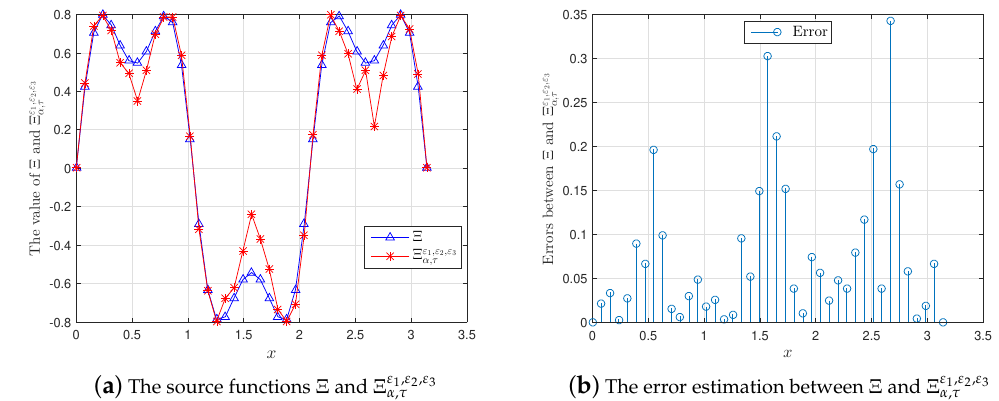
Figure 1. A comparison between Ξ and Ξ ε 1 , ε 2 , ε 3 α , τ for β = 1.5, X = T = 40, { ε 1 , ε 2 , ε 3 } := { 9 × 10 − 2 ,2 × 4 10 − 2 ,1 × 10 − 3 } , τ = 5.